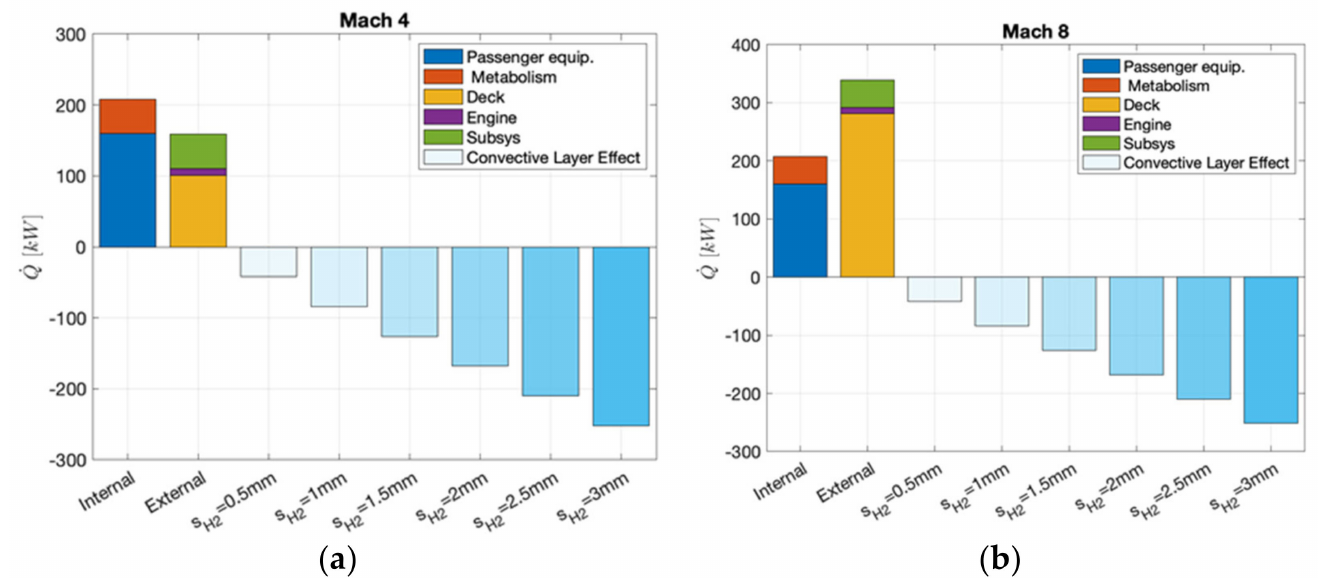
Figure 19. ( a ) Summary of the internal and external heat loads acting on the cabin and estimated air convective layer effect at Mach 4 flight conditions; ( b ) summary of the internal and external heat loads acting on the cabin and estimated air convective layer effect at Mach 8 flight